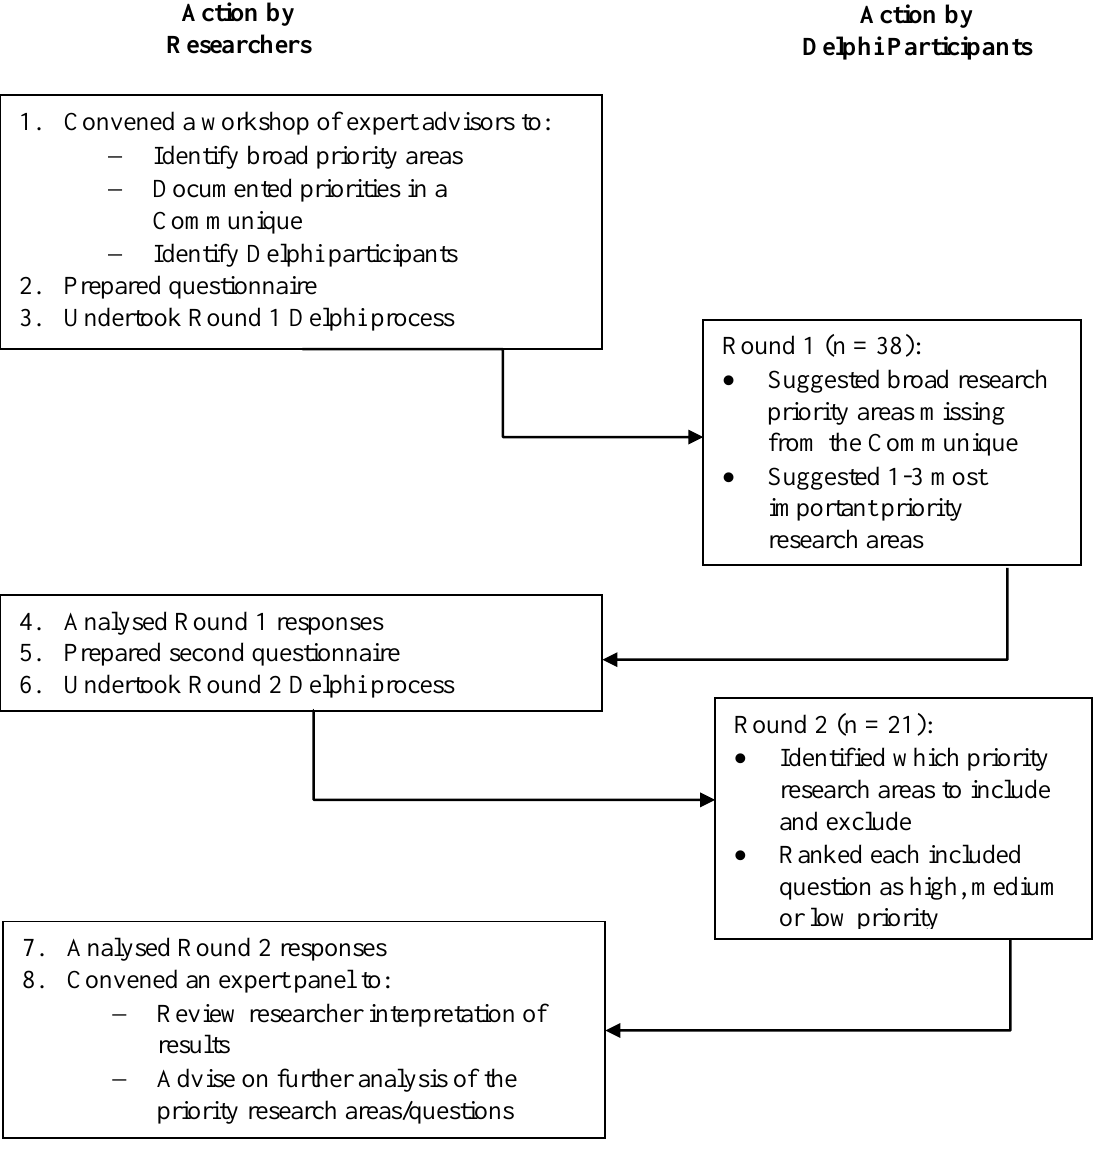
Figure 1. A summary of the study method and major